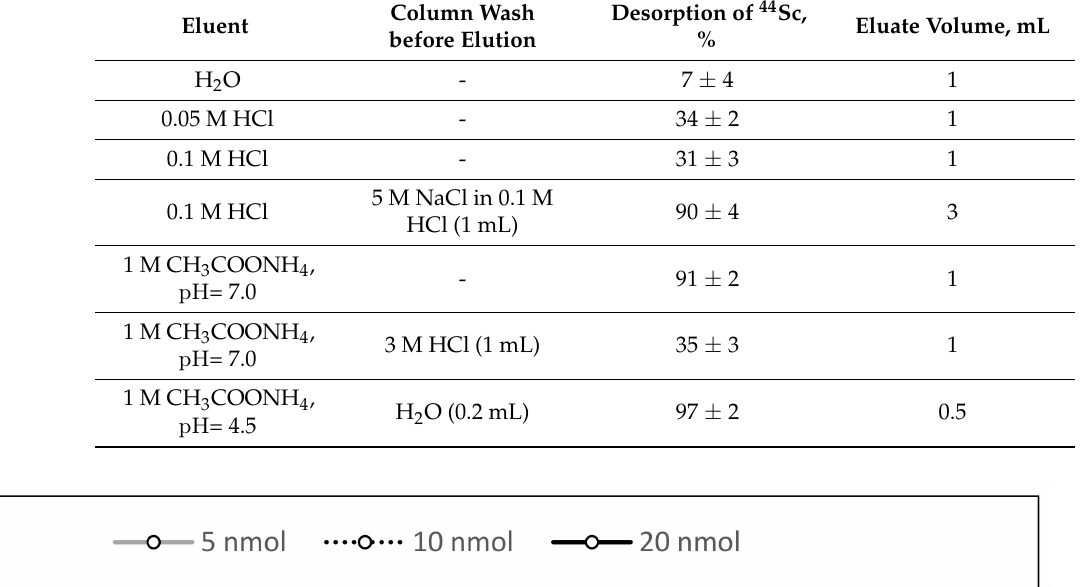
Table 7. The rate of 44 Sc desorption from TK221 resin with different eluents and resin washing conditions.